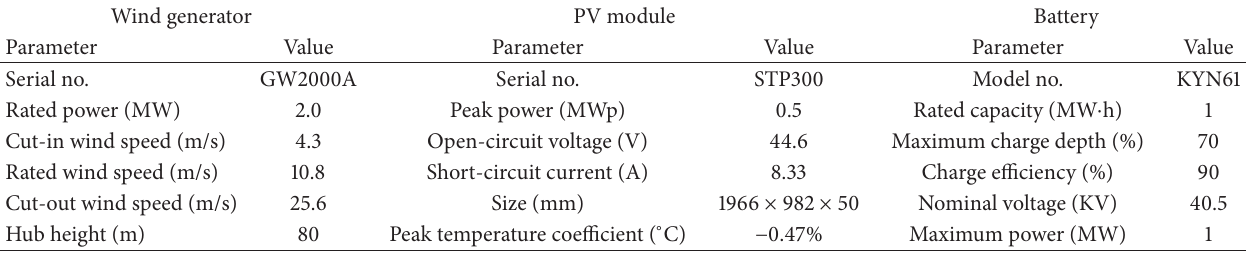
Table 1: Specification parameters of equipment.